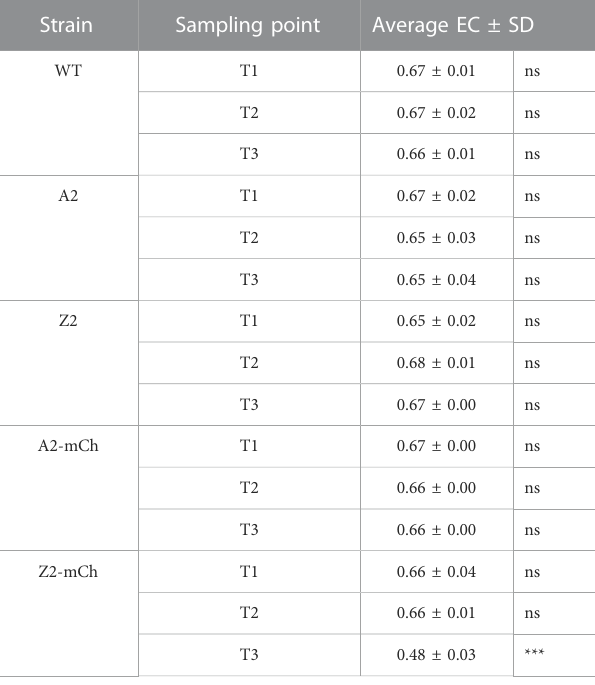
TABLE 4 Average adenylate energy charge (EC) ± standard deviation (SD) for each strain and sampling point, cultivated in de fi ned mineral medium in benchtop bioreactors. Signi fi cance levels for multiple comparisons from one- way ANOVA with Tukey ’ s HSD multiple comparisons tests are marked as ns: not signi fi cant; ***: p ≤